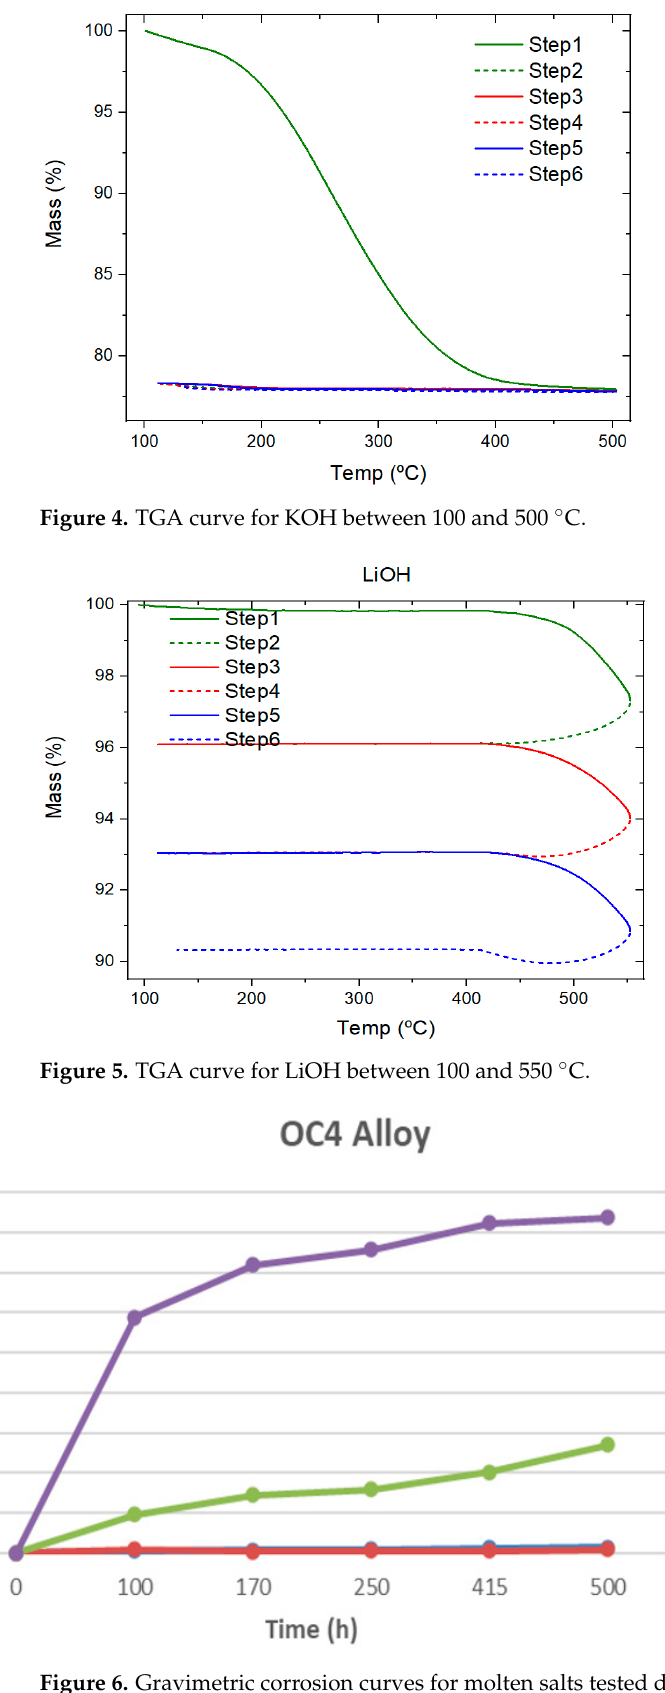
Figure 6. Gravimetric corrosion curves for molten salts tested during 500 h of immersion.